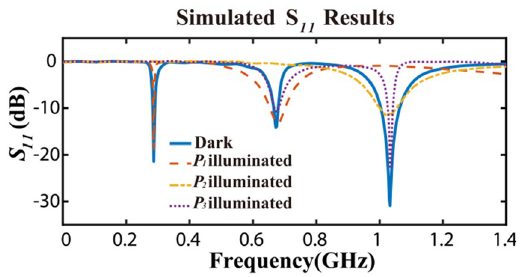
Figure 4. Simulation results of S 11 parameters in different illumination states.